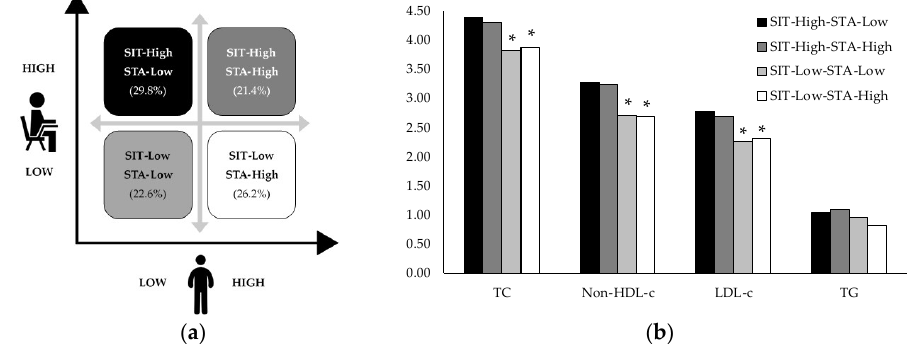
Figure 2. Clusters of sitting time with standing ( a ) and cardiometabolic health outcomes of adolescents within each cluster ( b ). Note: TC: total cholesterol; Non-HDL-c: non-HDL-cholesterol; LDL-c: low-density lipoprotein cholesterol; TG: triglycerides; SIT: sitting time; STA: standing time. * p < 0.05 vs. SIT-High; STA-Low. Power (1 −β err prob) = 0.77. All models were adjusted for daily waking hours, device wear (days), age, smoking status, body mass index (BMI), and MVPA daily recommendation. Data of TG were transformed from the log scale for better interpretation.